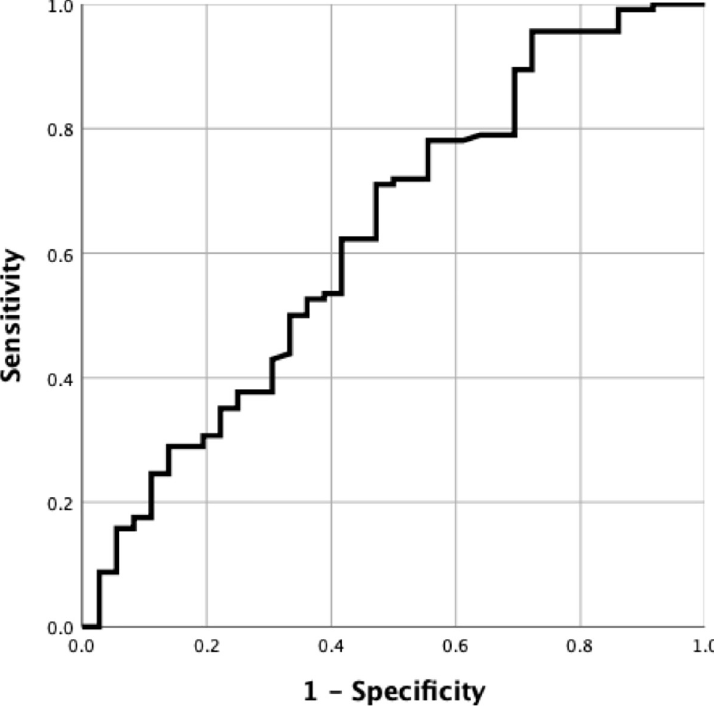
Fig 3. Muscle densitometry accuracy in classifying the unit of hospitalization. Receiver operating curve demonstrating the overall performance of muscle densitometry, expressed in Hounsfield unit, in classifying patients requiring hospitalization in intensive care unit (62.9% accuracy).